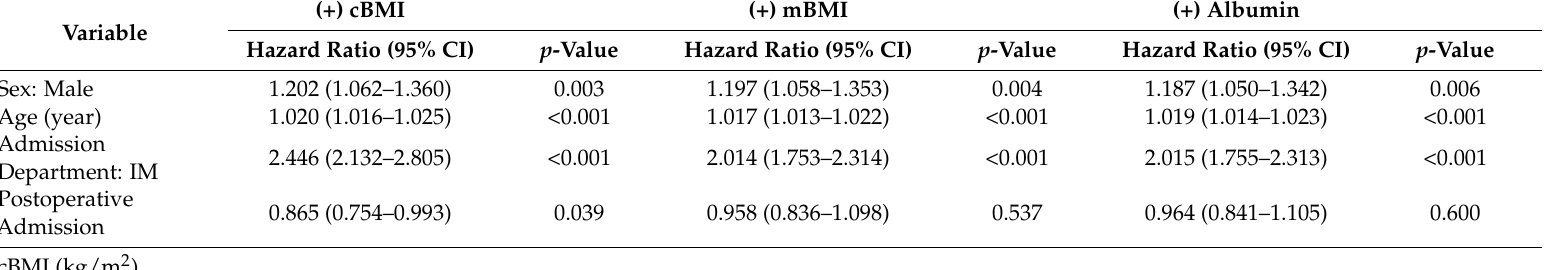
Table 3. Multivariate Cox regression analysis for one-year mortality after ICU